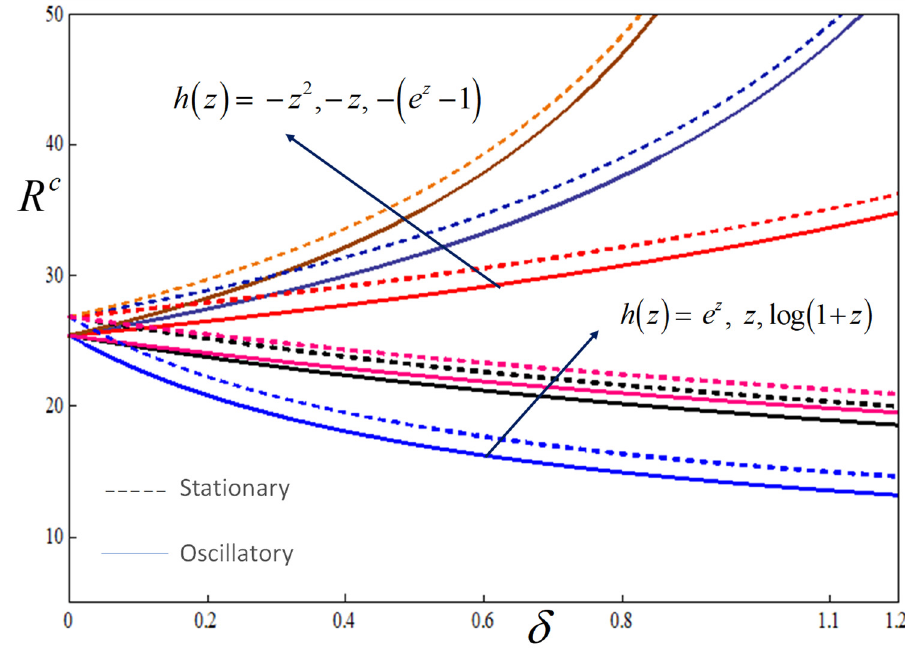
Figure 4. Plot of R c versus δ for different scenarios of gravity with Le = 0.5, Rs = 10, Da = 0.1, Figure 4. Plot of c R versus δ for different scenarios of gravity with 0.5, 10, = = Le Rs 0.1, = Da ξ = 0.5, η = 0.5 and δ = 0.5, 0.5 ξ η= = and 0.5. δ=